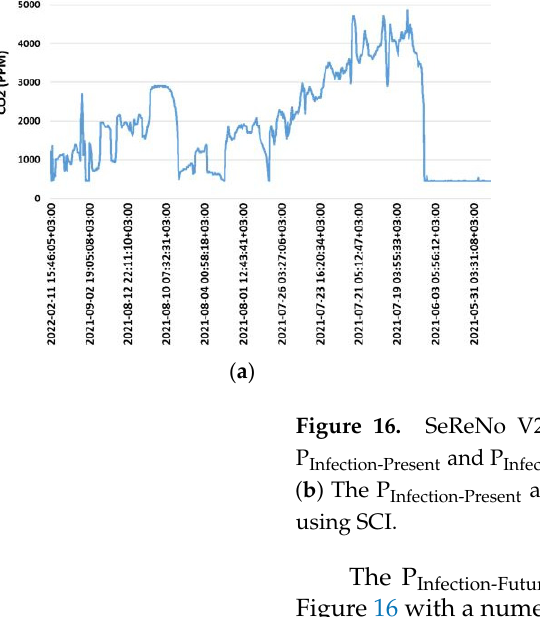
Table 4. Regression Parameter Setting.